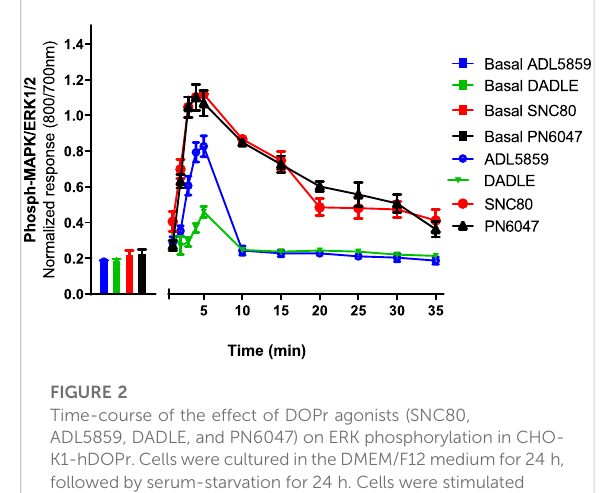
FIGURE 2 Time-course of the effect of DOPr agonists (SNC80, ADL5859, DADLE, and PN6047) on ERK phosphorylation in CHO- K1-hDOPr.Cellswerecultured intheDMEM/F12 medium for24 h, followed by serum-starvation for 24 h. Cells were stimulated with DOPr agonists (10 µM) for the indicated times, followed by rapid fi xation with PFA (4% w/v) solution. Detection of total and phospho-ERK levels was carried out as stated in the Methods Section.IndividualERKphosphorylationvalueswerenormalizedto the corresponding total-ERK values. The bars show basal ERK responses from unstimulated cells. The data shown are mean ± SEM values from 5 independent experiments performed in